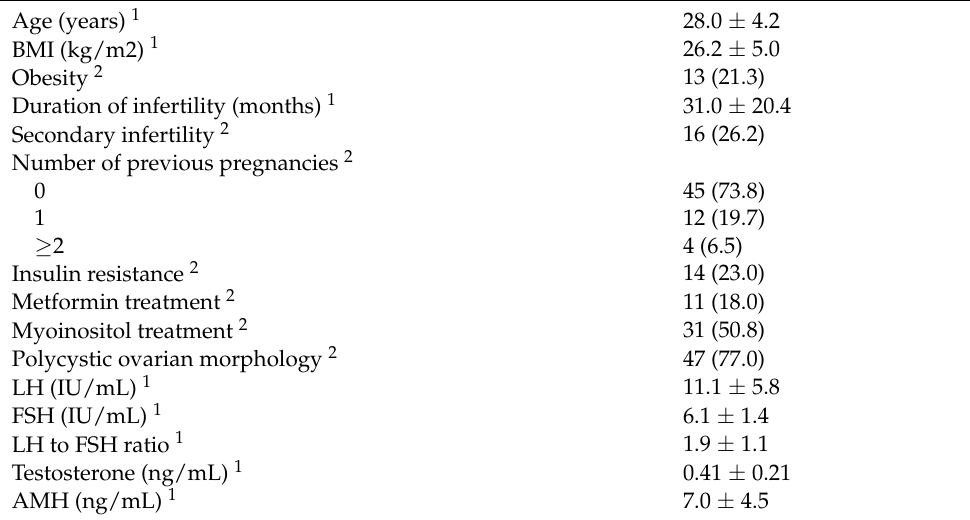
Table 1. Basic patient characteristics and basic hormonal profile of the 61 anovulatory, infertile PCOS